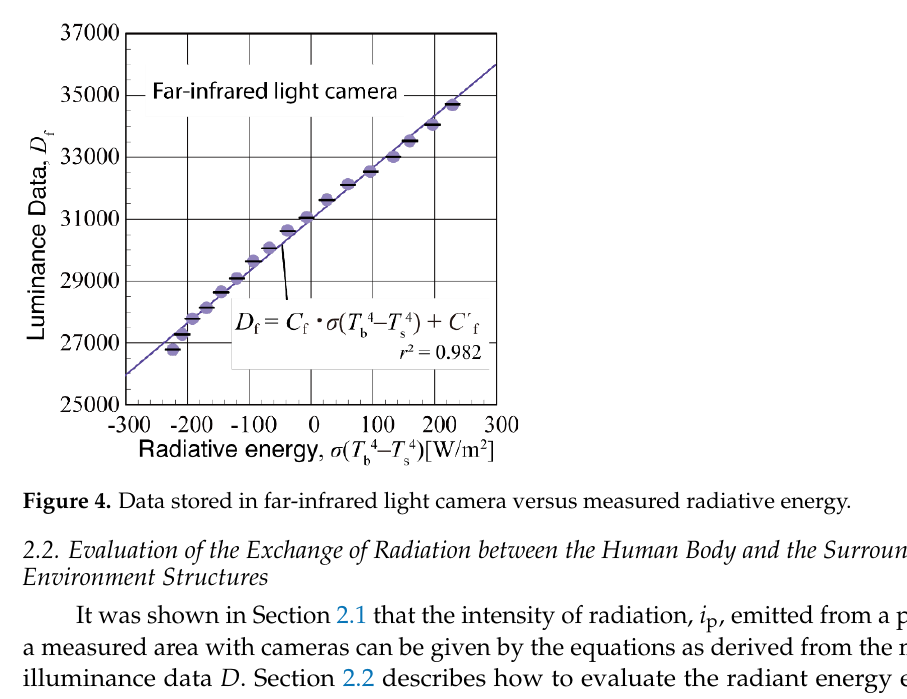
(10) Figure 6. Overview of how to project onto a virtual surface.